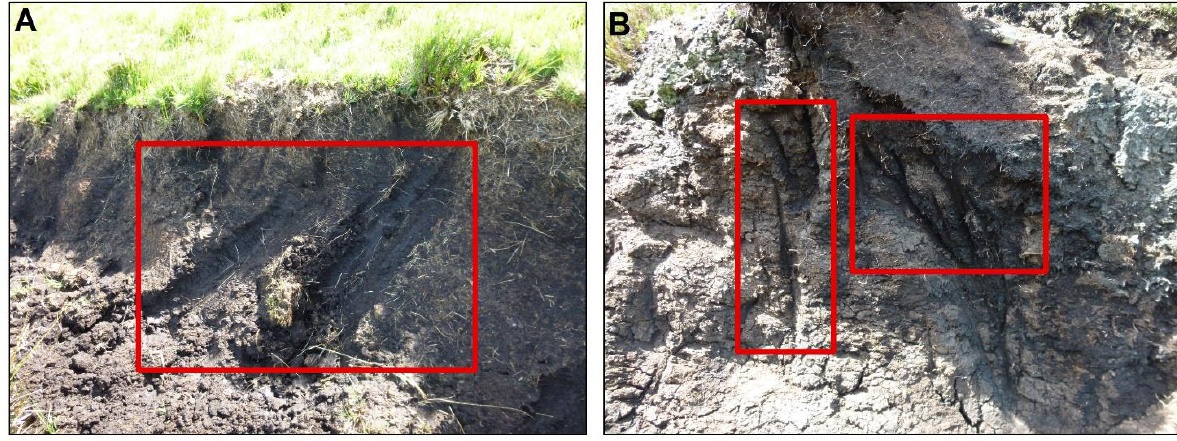
Figure 7. A) Peat disturbance from hooves and B) striations in exposed peat left by livestock horns. Photographs taken by Guaduneth Chico in July